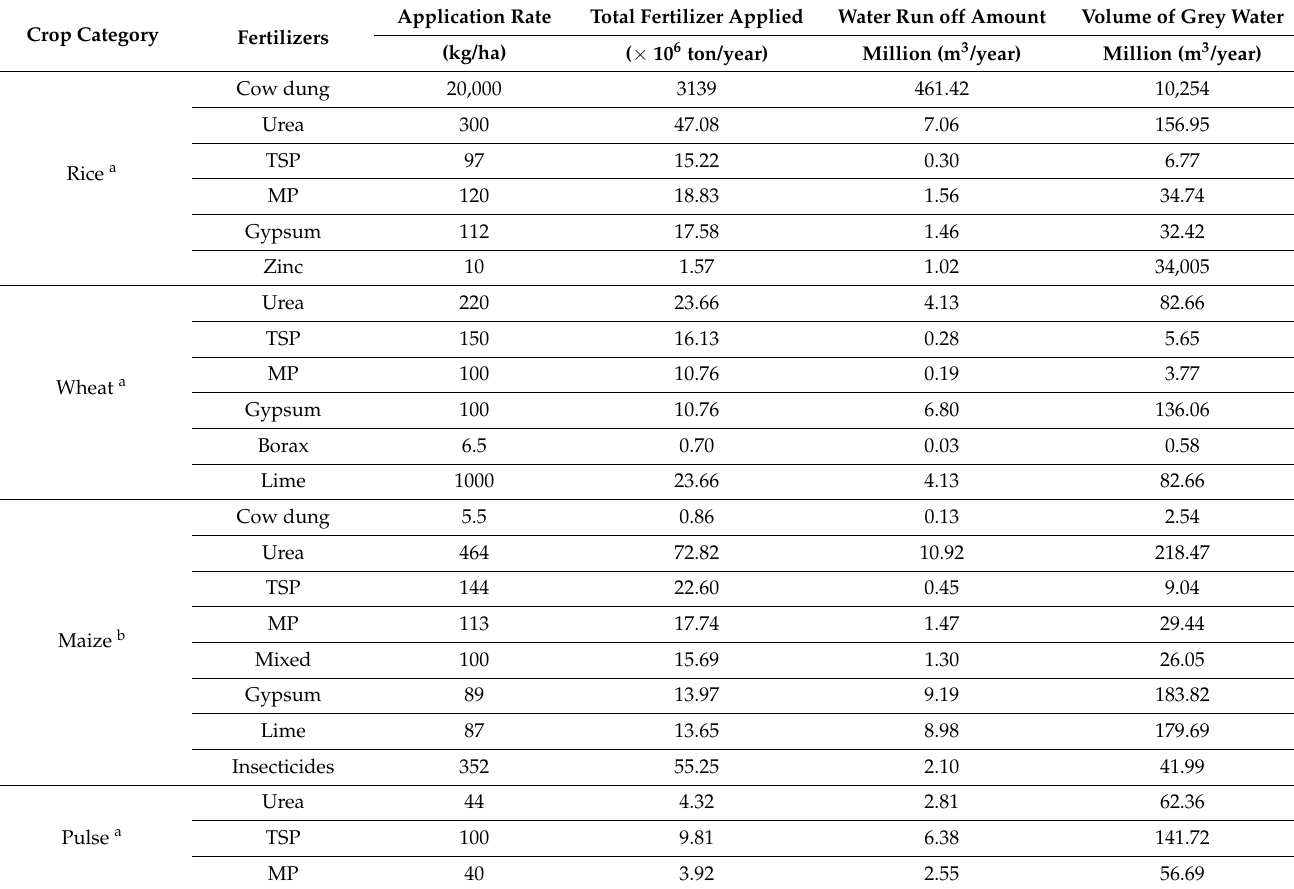
Table A2. Fertilizer application rate in selected crop cultivation of Bangladesh.